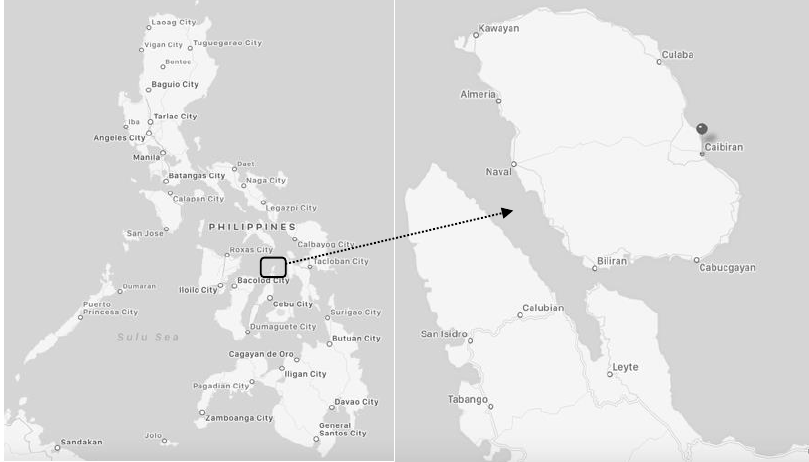
Figure 1. Location of the case study site. Source: Google Earth Image: Google, Maxar